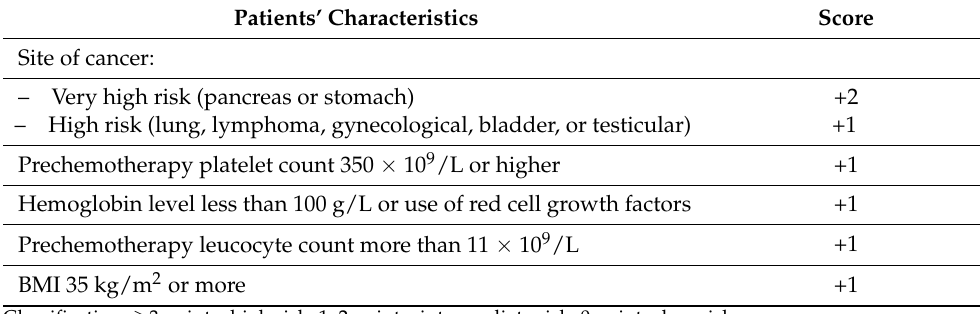
Classification: ≥ 3 points: high risk, 1–2 points: intermediate risk, 0 points: low